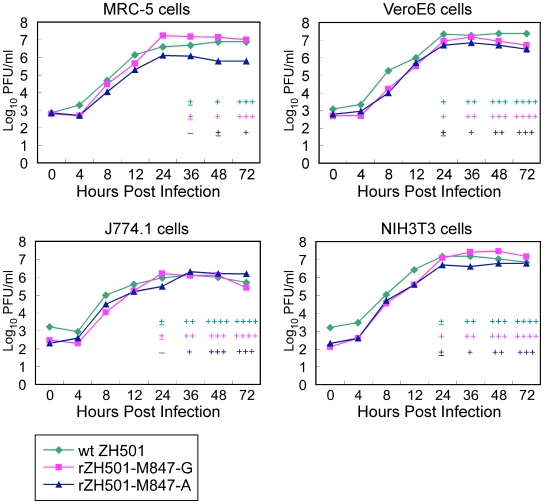
Growth curve of ZH501, rZH501-847-A and rZH501-847-A in various cell lines.VeroE6 cells, NIH3T3 cells, J774.1 cells and MRC-5 cells were inoculated with ZH501, rZH501-847-A or rZH501-847-A at an moi of 0.02. Culture fluids were collected and virus titers were determined by a plaque assay using VeroE6 cells. Virus growth curve of one representative experiment for each cell type is shown. Progression of CPE is represented by the symbols: +, ++, +++ or +++. +  =  up to 25% of cell sheet affected showing cytolysis and swollen cells. ++  =  up to 50% of cell sheet affected showing lysed cells, floating cells and cell debris +++  =  up to 75% of cell sheet affected showing significant cell lysis and increased amounts of cell debris in culture fluid. ++++  =  cell sheet destroyed with complete cytolysis.